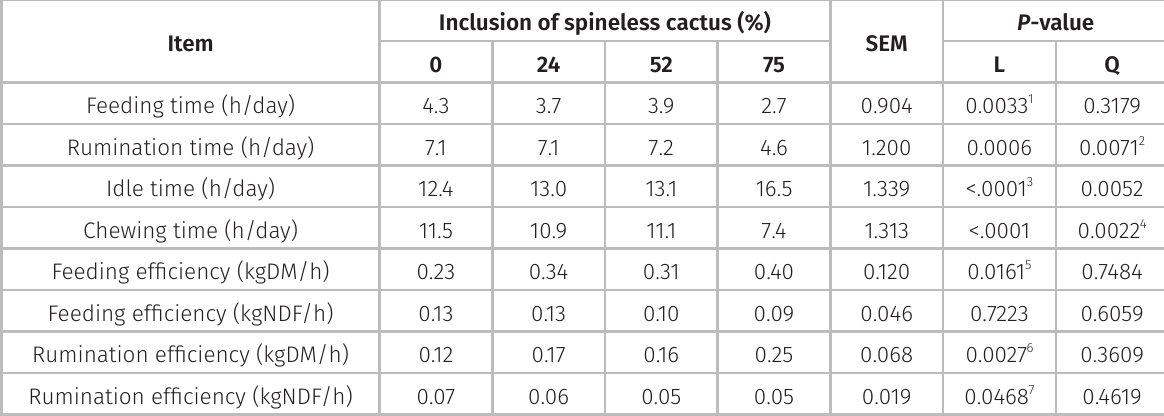
Table IV. Ingestive behavior of lambs fed with increasing levels of forage palm inclusion in the diet.